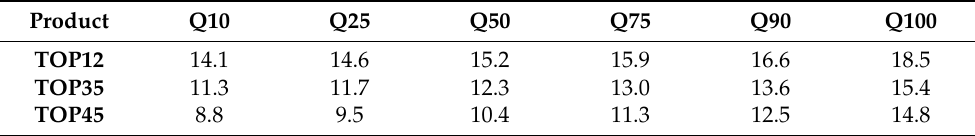
Table 1. Quantiles (10, 25, 50, 75, 90, and 100) for the maximum TOP field of each product (TOP12, Figure 5. Same as Figure 4, for the TOP45, with a height threshold of 4 km. Areas with white color TOP35, and in left panel indicate that maximum TOP45 did not exceed 6 km at any time during the period of study.